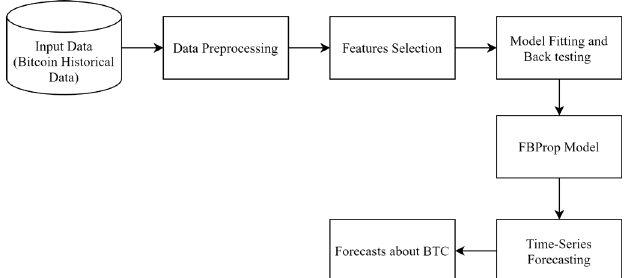
Figure 3. ARIMAX Model for BTC Prediction